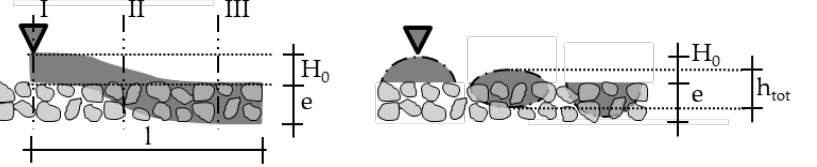
Figure 6. Measurement of the penetration depth e and the total height h tot of the strands; I: Not penetrated cement paste with height H 0 ; II: Partly penetrated cement paste; III: Completely penetrated cement paste.